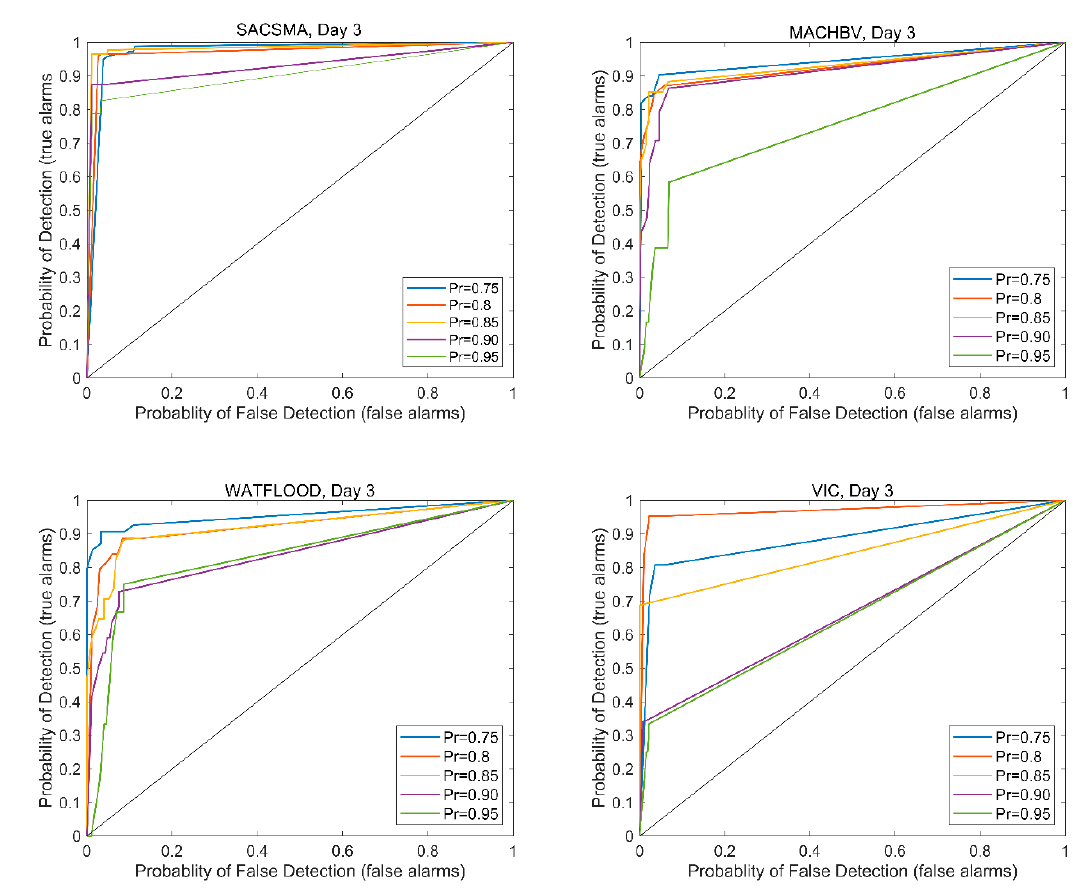
Figure 10. Relative Operating Characteristic ( ROC ) curves drawn for probability thresholds exceeding 75, 80, 85, 90, and 95 percentile reservoir inflows for three days ahead forecast. The four plots are for four different hydrological models.